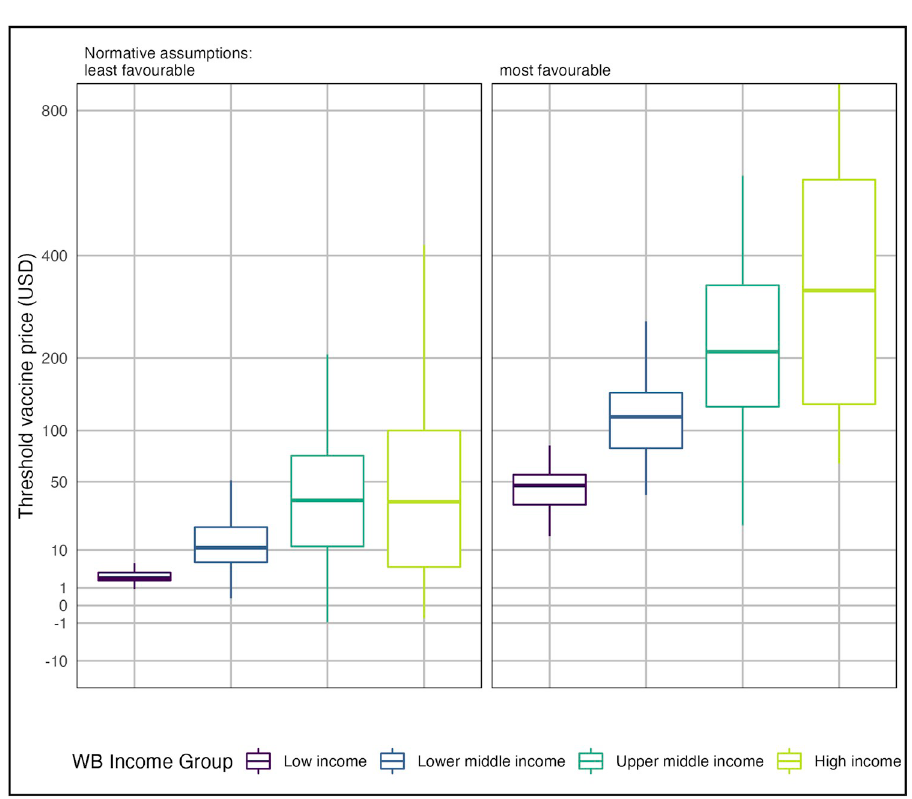
Fig 5. Distribution of GBS vaccine threshold prices among countries within each World Bank income group under most and least favourable normative assumptions (see Table 1). Threshold vaccine prices above $800 per dose are not shown. Least favourable normative assumptions were the use of an empirical CET, 3% discounting of QALYs, and exclusion of stillbirth QALYs. Most favourable assumptions were the use of 1 × GDP per capita CETs, 0% discounting of QALYs, and inclusion of stillbirth QALYs. CET, cost-effectiveness threshold; GBS, Group B Streptococcus; GDP, Gross Domestic Product; QALY, quality-adjusted life